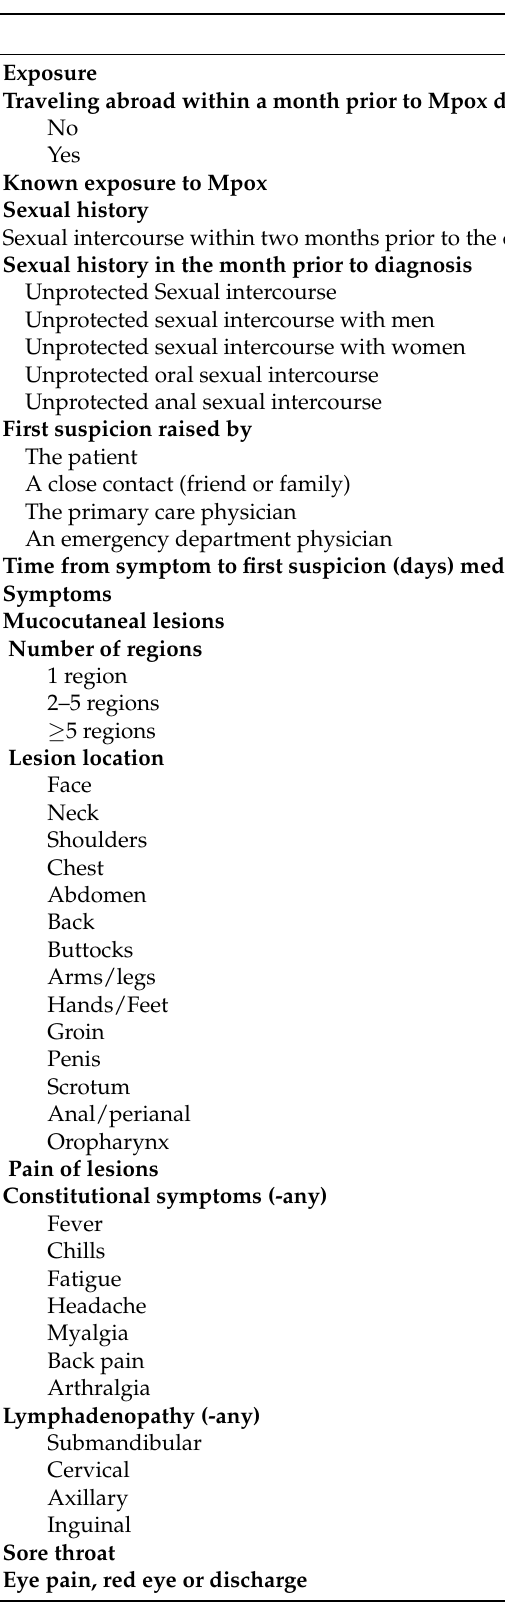
Table 4. Detailed exposure and symptomatology information of 18 individuals with